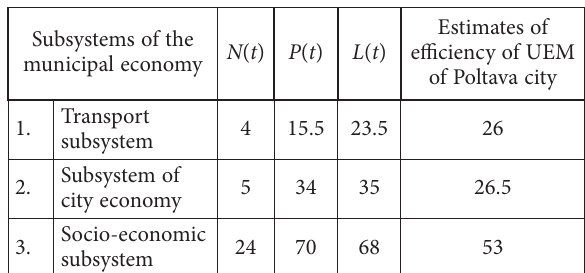
Figure 9. The landscape of the efficiency of the urban environment metabolism Poltava city, depending on the Table 2. Interim estimates of the UEM efficiency indicator amount of energy consumed for the heating of buildings and in the city of Poltava municipal solid waste produced by the population